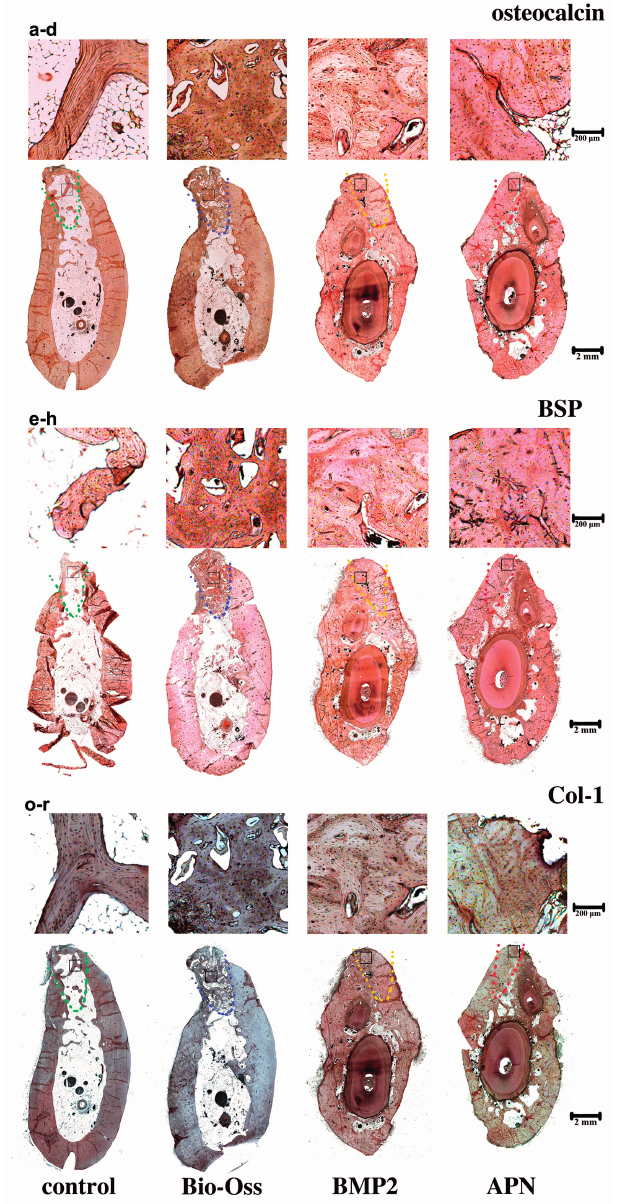
Figure 6. Expression of osteogenic related protein following the different 12-week treatments in the extraction sockets. Imunohistochemical analysis of extraction socket trabecular bone sections for ( a – d ) OCN (Osteocalcin); ( e – h ) BSP (Bone sialoprotein) and ( o – r ) Col-1 (Collagen 1). ( a , e , o ) the control group; ( b , f , p ) Bio-Oss group; ( c , g , q ) BMP2 group; ( d , h , r ) APN group. The black square represents the magnifying area. The dashed line represents the extraction sockets. Magnification: upper panel 40×; lower panel 4×. n = 4 for each